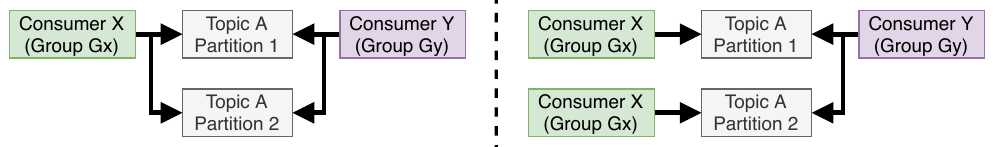
Figure 2. Horizontal scalability through group based partition assignment in Apache Kafka. Left: One consumer of type X and group Gx and one consumer of type Y and group Gy reading from a topic with two partitions, each consumer is assigned all partitions. Each consumer therefore handles the entire workload. If the data stream becomes larger, it is possible that consumer X is no longer able to handle the workload, causing it to lag behind. Right: To deal with this change in behavior, a second instance of consumer X and group Gx is added. Kafka divides the partitions over consumers of the same group, lowering the workload of both instances (each instance handling 50% of the data stream). This enables horizontal scalability of all consumers in the overall